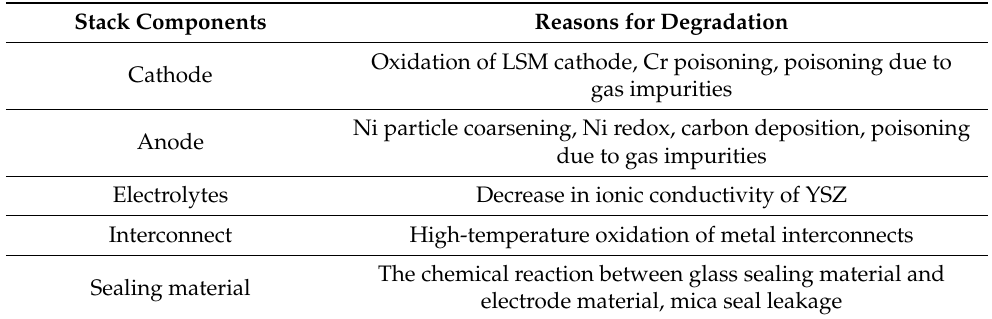
Table 1. Reasons for stack material degradation.